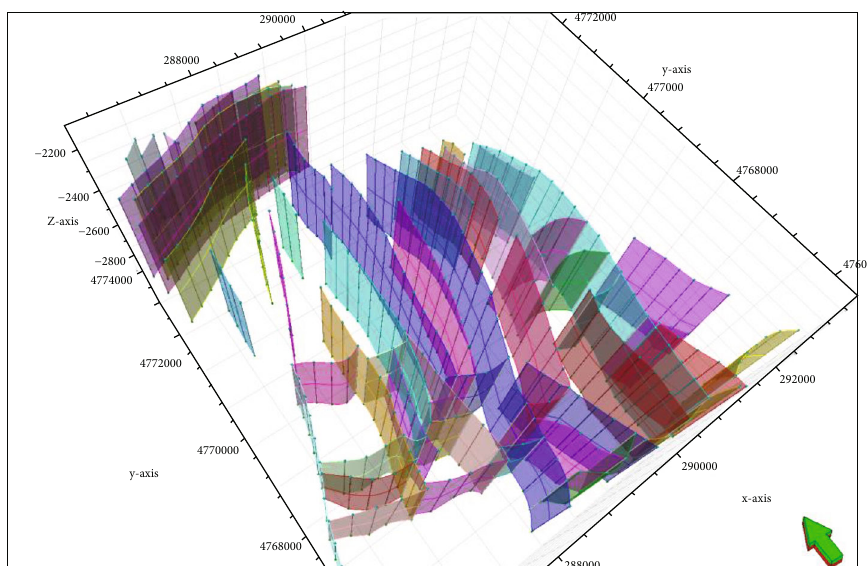
Figure 10: Fault model of the study area.